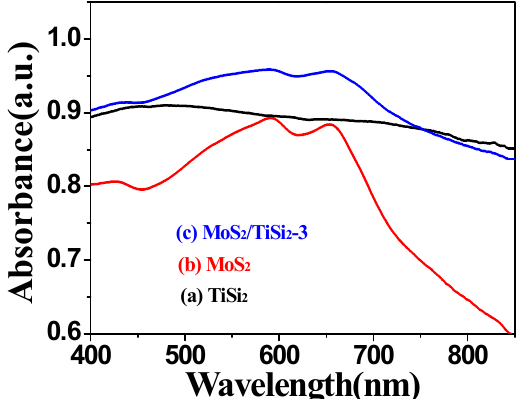
Figure 4. The UV–vis absorption spectra of the obtained samples.